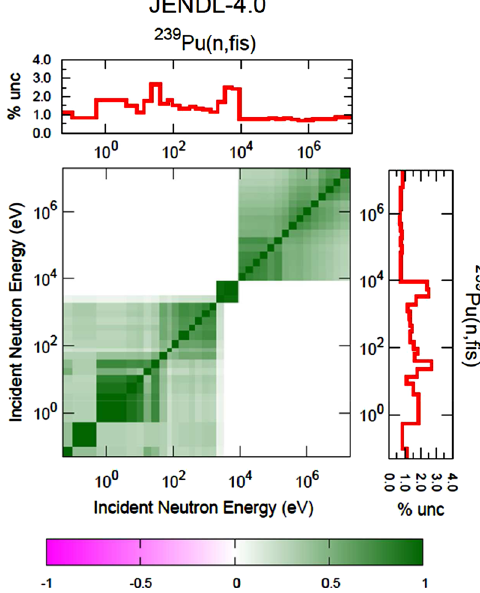
3. 239 Pu fi ssion uncertainty and energy correlation: